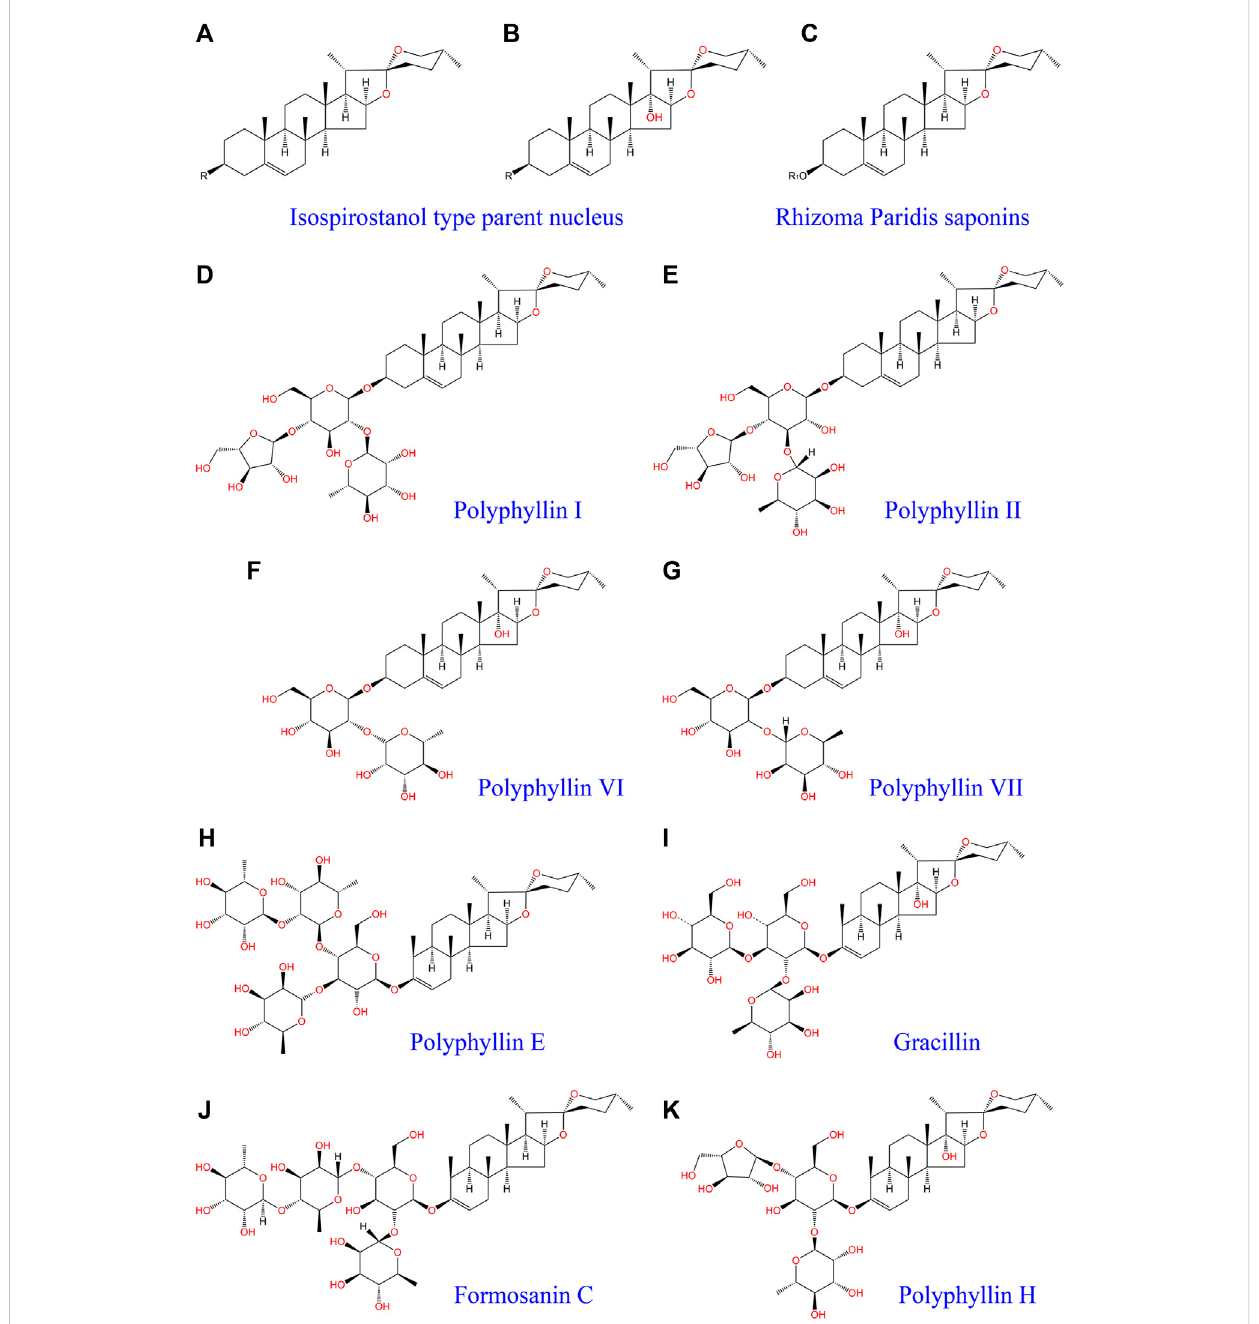
FIGURE 1 Isospirostanol type parent nucleus (A,B) , Rhizoma Paridis saponins (C) , polyphyllin I (D) , polyphyllin II (E) , polyphyllin VI (F) , polyphyllin VII (G) , polyphyllin E (H) , Gracillin (I) , Formosanin C (J) , and polyphyllin H (K) . “ R1 ” indicates that different functional groups represent different types of saponins with different molecular